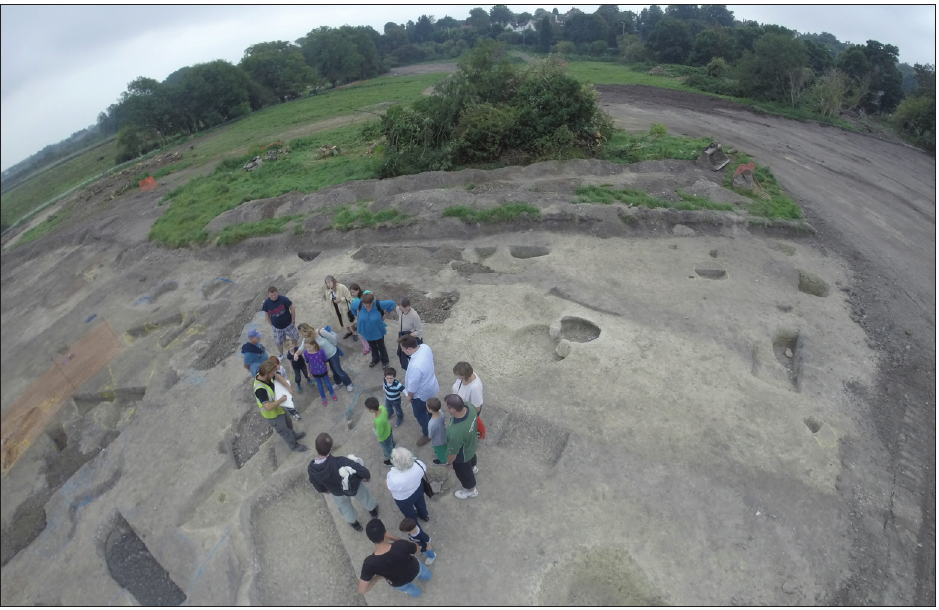
Figure 1: A public open day visit to the heart of the Iron Age marsh-side settlement. Photo: CAA: Archaeology